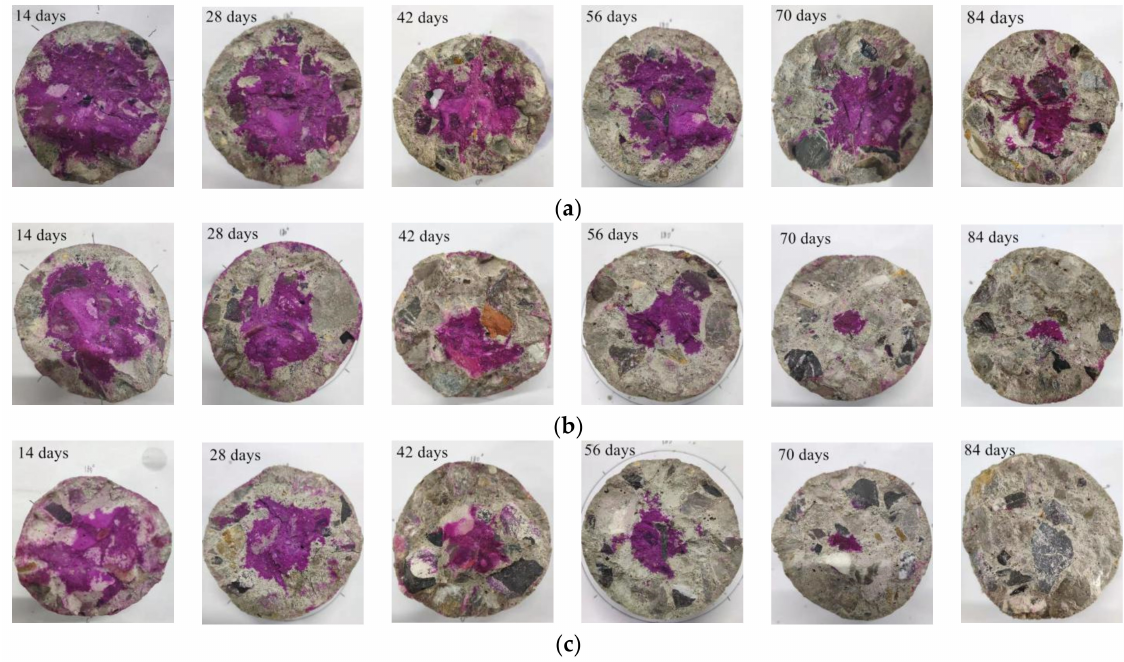
Figure 3. Typical specimens after different carbonation periods. ( a ) NAC; ( b ) RAC50; ( c ) RAC100.